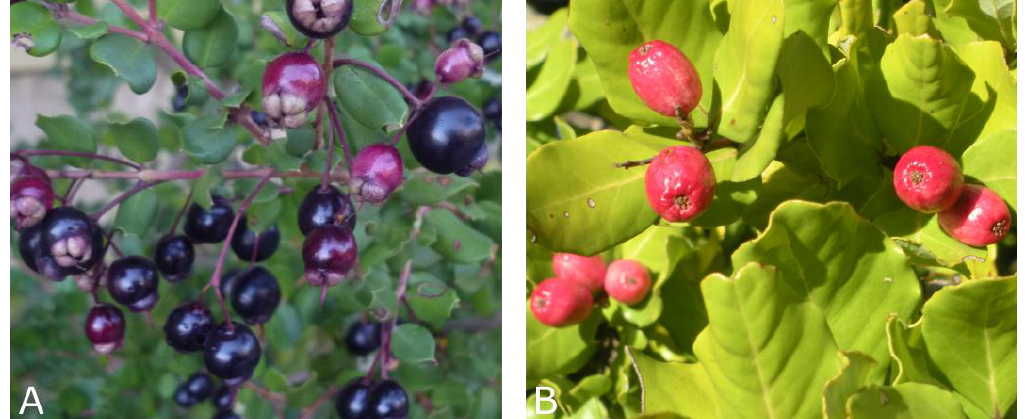
Figure 1. Branches with leaves and fruits of arrayan and peumo. ( A ) Arrayan [ Luma apiculata (DC.) Burret.] *; ( B ) Peumo [ Cryptocarya alba (Molina) Looser] **. Photography credit to Carlos R. Figueroa (*) and Lida Fuentes (**).